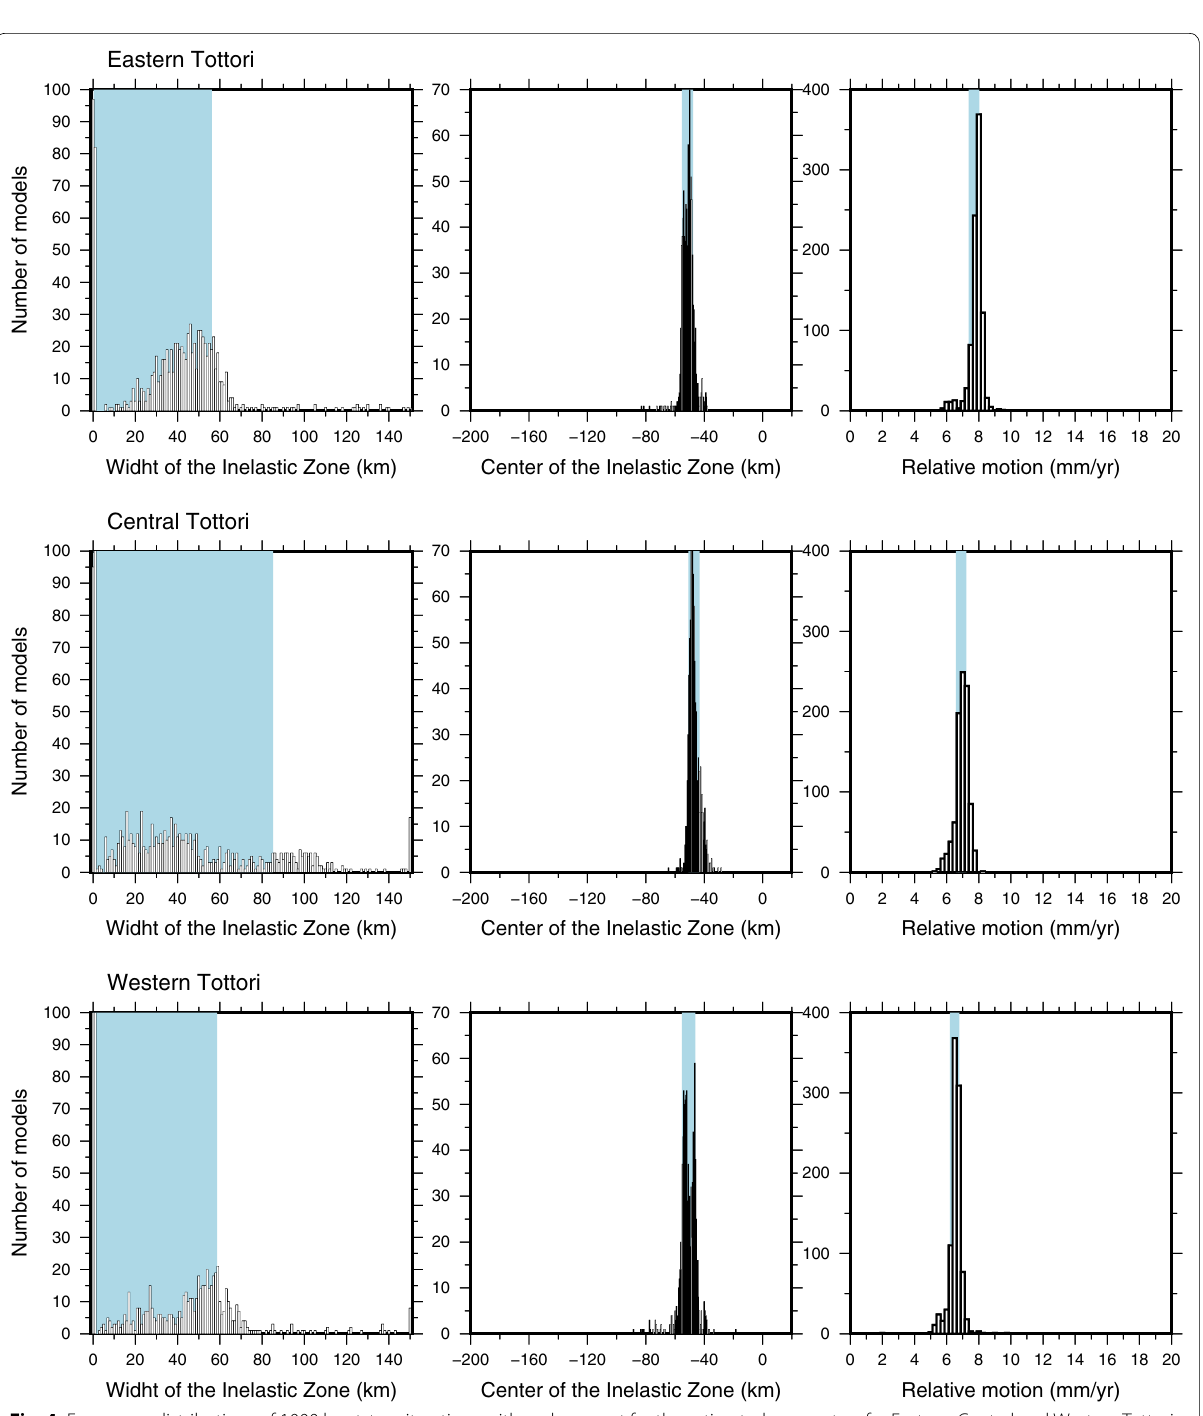
Fig. 4 Frequency distributions of 1000 bootstrap iterations with replacement for the estimated parameters for Eastern, Central and Western Tottori. Blue area denotes the 68% confidence interval for each